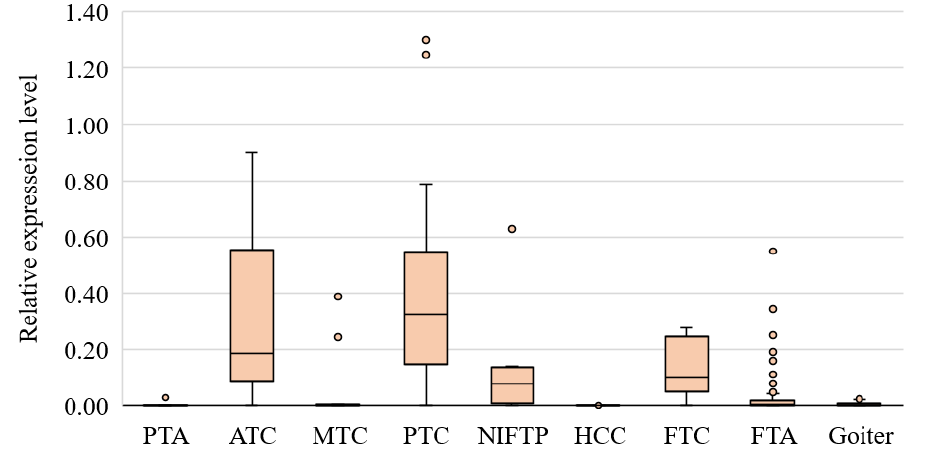
Figure 2. HMGA2 mRNA expression in goiters and thyroid/parathyroid tumors, presenting the median value, upper and lower quartiles, a nonoutlier range, and outliers